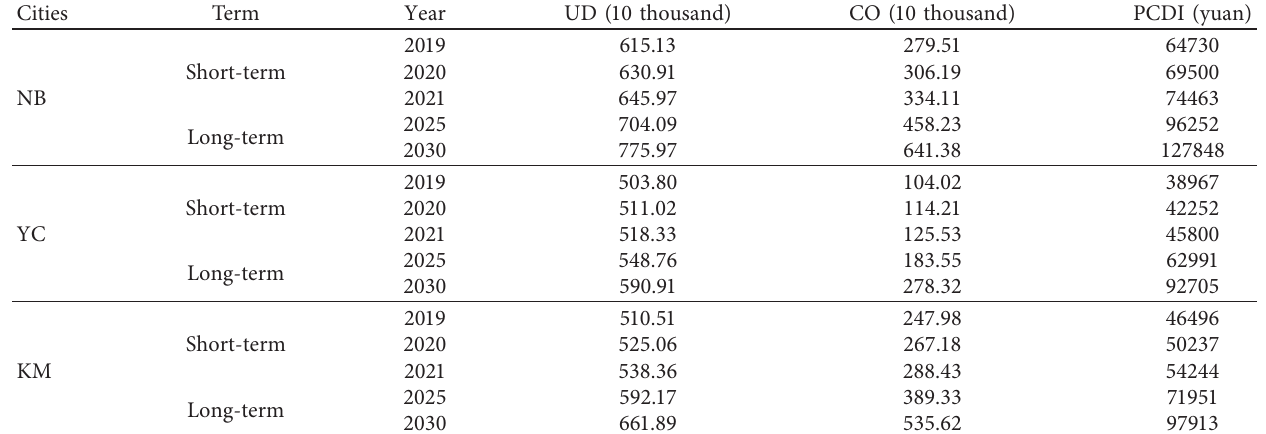
Table 8: Time series prediction for 2019–2021 (aggressive).